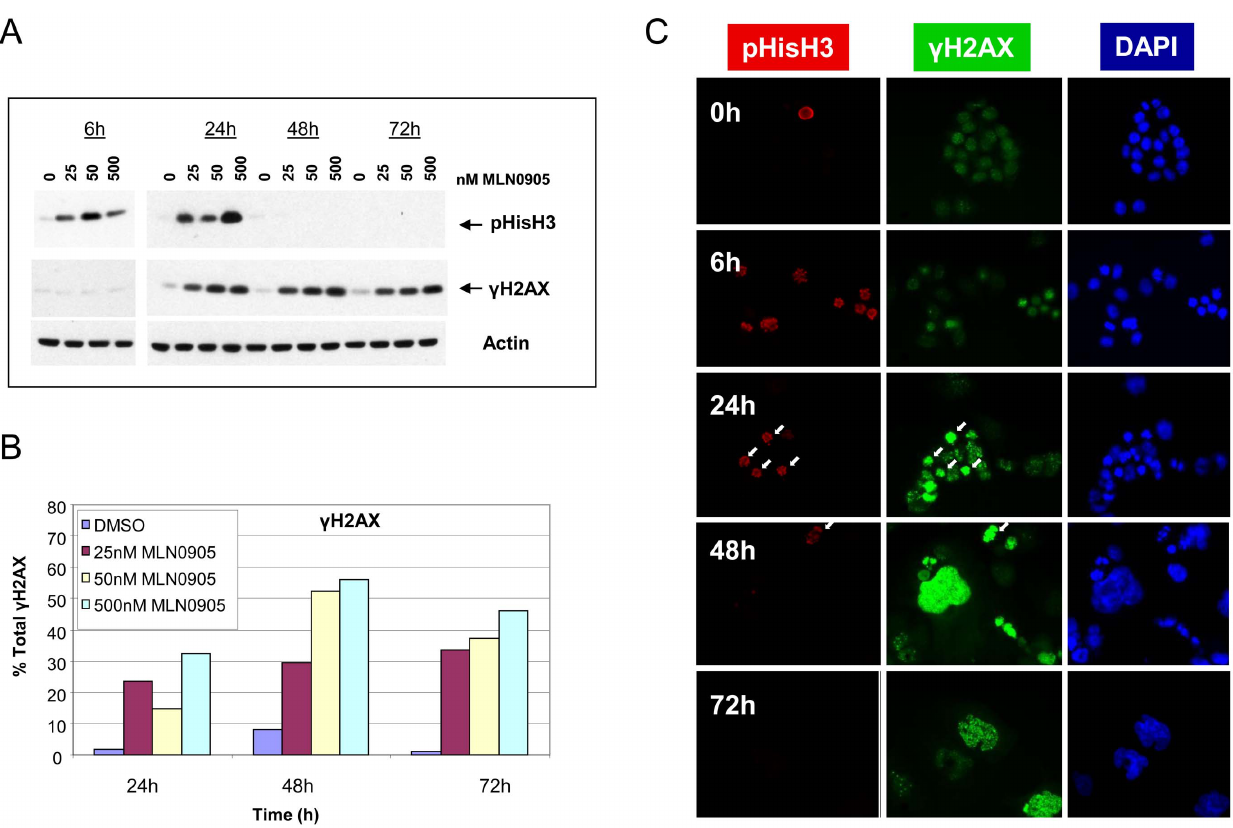
Figure 1. Plk1 inhibition leads to transient mitotic arrest followed by DNA damage in HCT116 cells. Cells were treated with increasing concentrations of MLN0905 and at indicated times analyzed for mitotic arrest (via pHisH3) and DNA damage (via c H2AX). A) Immunoblotting indicates transient mitotic arrest leads to DNA damage (representative blot shown from two independent experiments). B) The same samples used in A) were quantified for DNA damage ( c H2AX staining) using FACS analysis. C) In a separate experiment immunofluorescent chemistry was also used to demonstrate mitotic arrest precedes DNA damage (representative images shown from two independent experiments; 50 nM MLN0905 used).